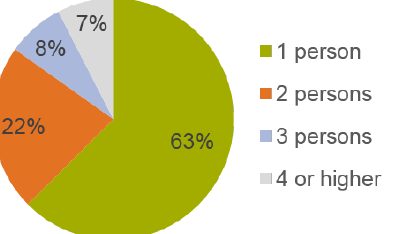
Figure 6. Share of one, two, three, and four or more person